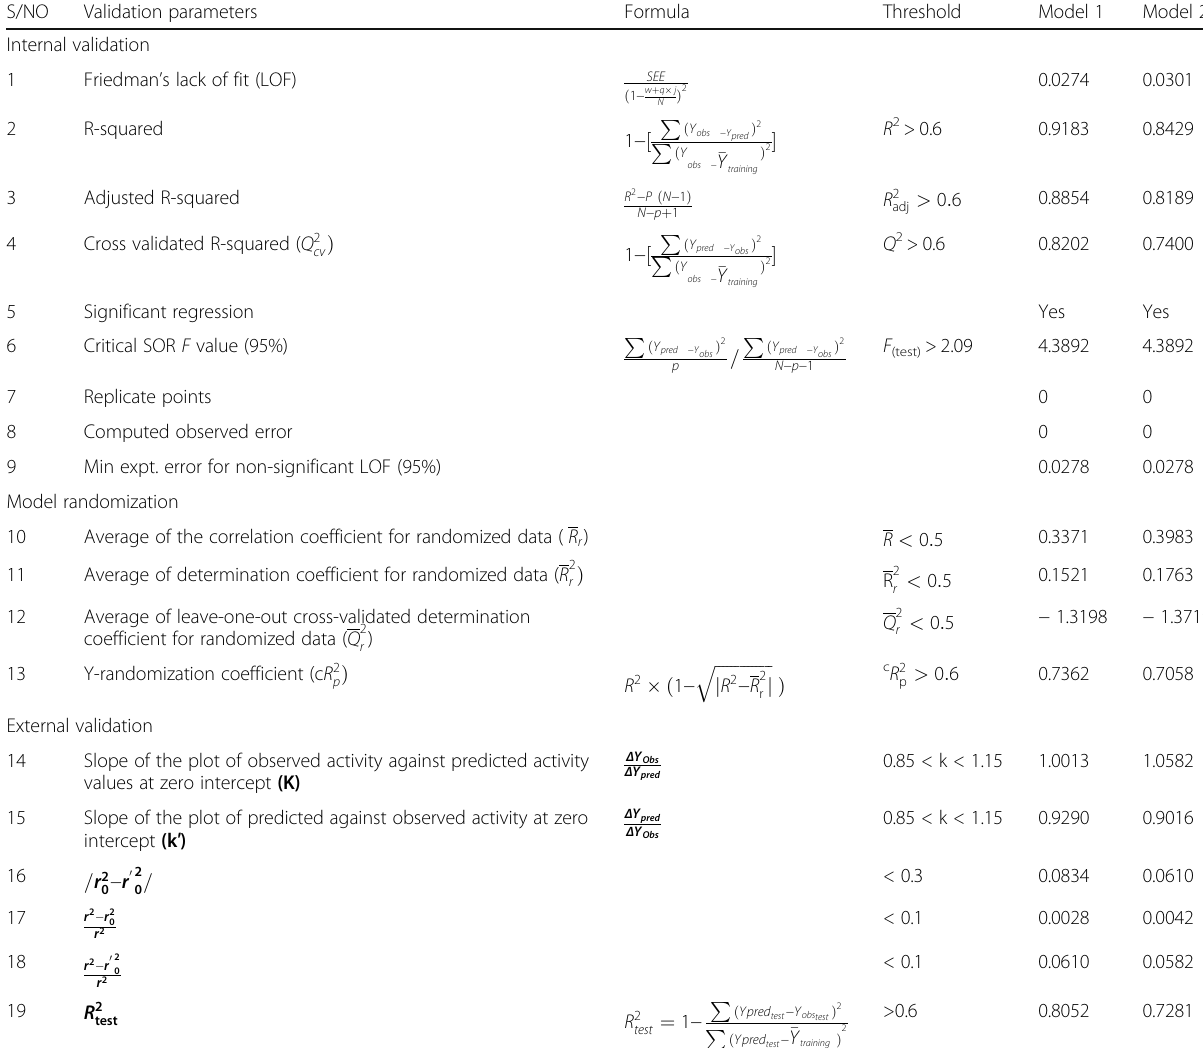
Table 5 Internal and external validation parameters for each model Validation